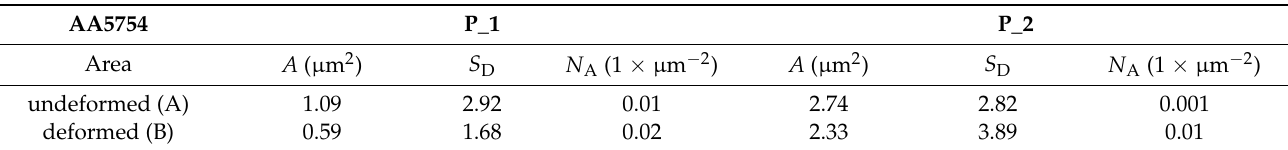
Table 2. The mean surface area ( A ), standard deviation ( S D ), and number per 1 µ m 2 ( N A ) of coarse intermetallic particles P_1 and